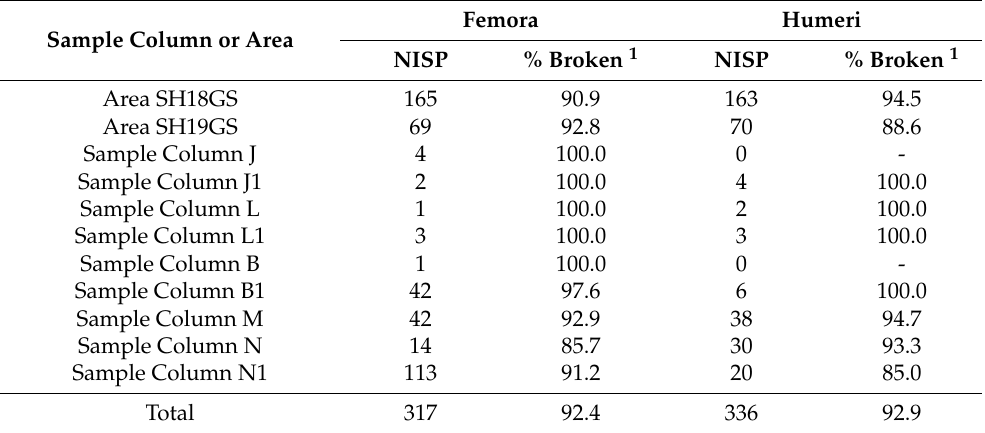
Table 3. Postcranial fragmentation data, disaggregated by sample column or